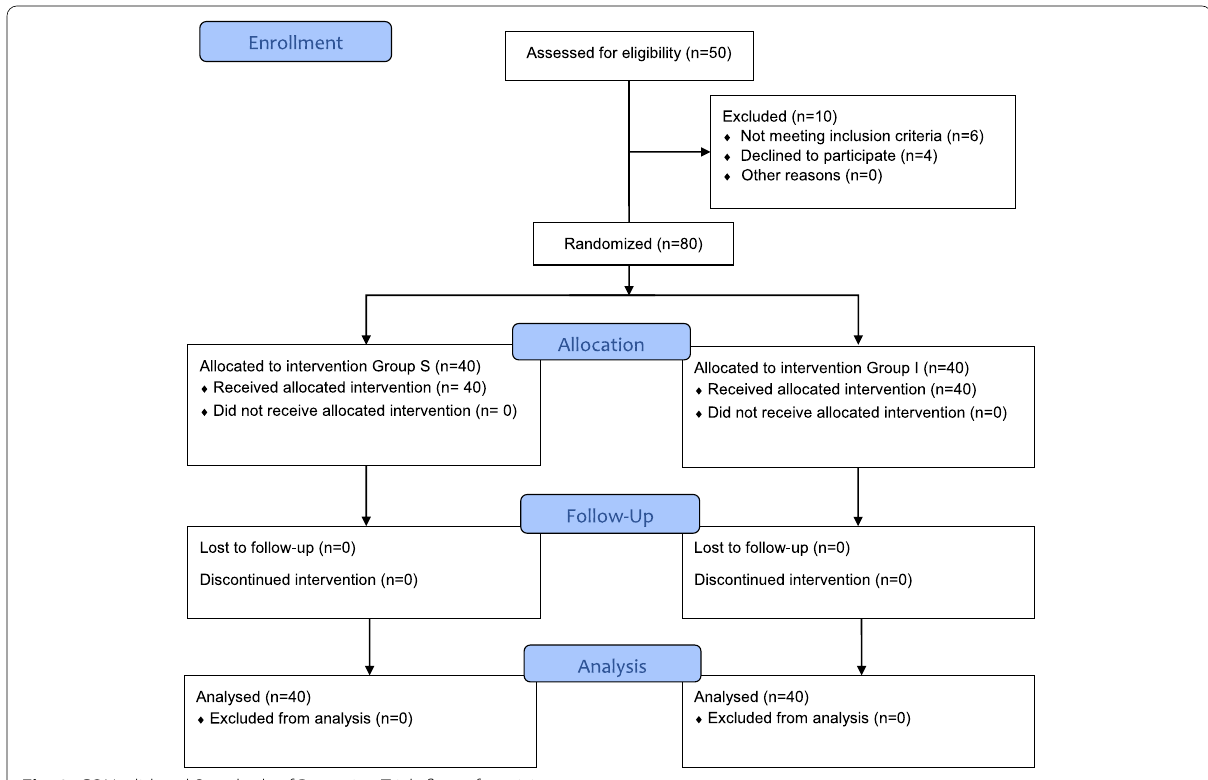
Fig. 2 CONsolidated Standards of Reporting Trials flow of